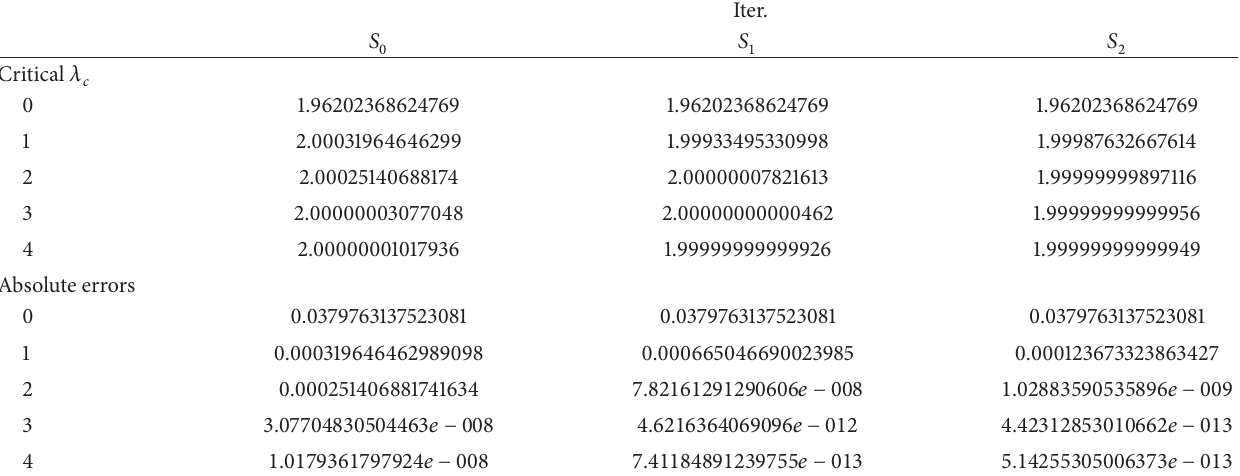
Table 5: Iterative convergence for different schemes for the critical value of 𝜆 𝑐 for Frank-Kamenetzkii problem, 𝑁 = 200 .